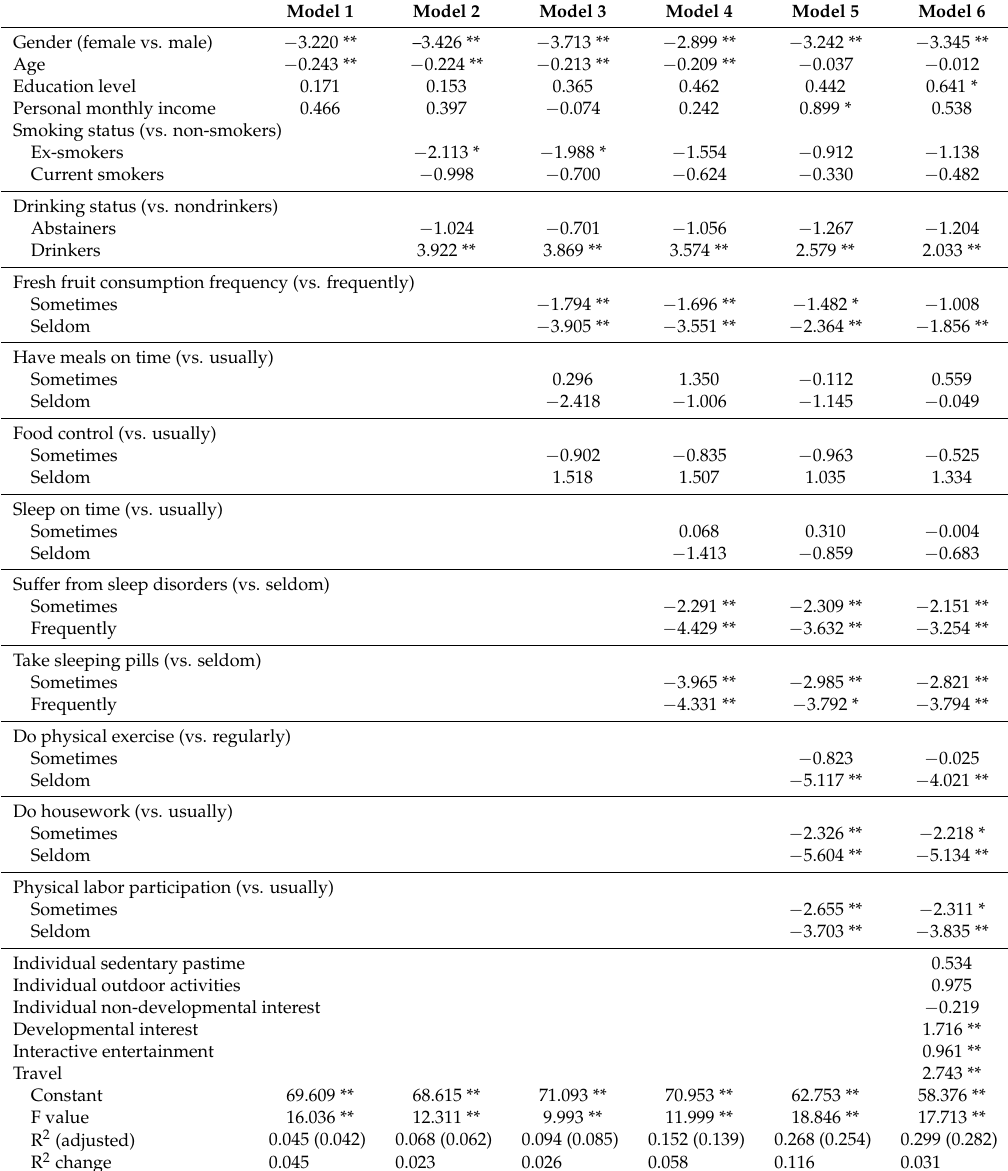
Table 3. Hierarchical linear regression models on the physical component summary score of the